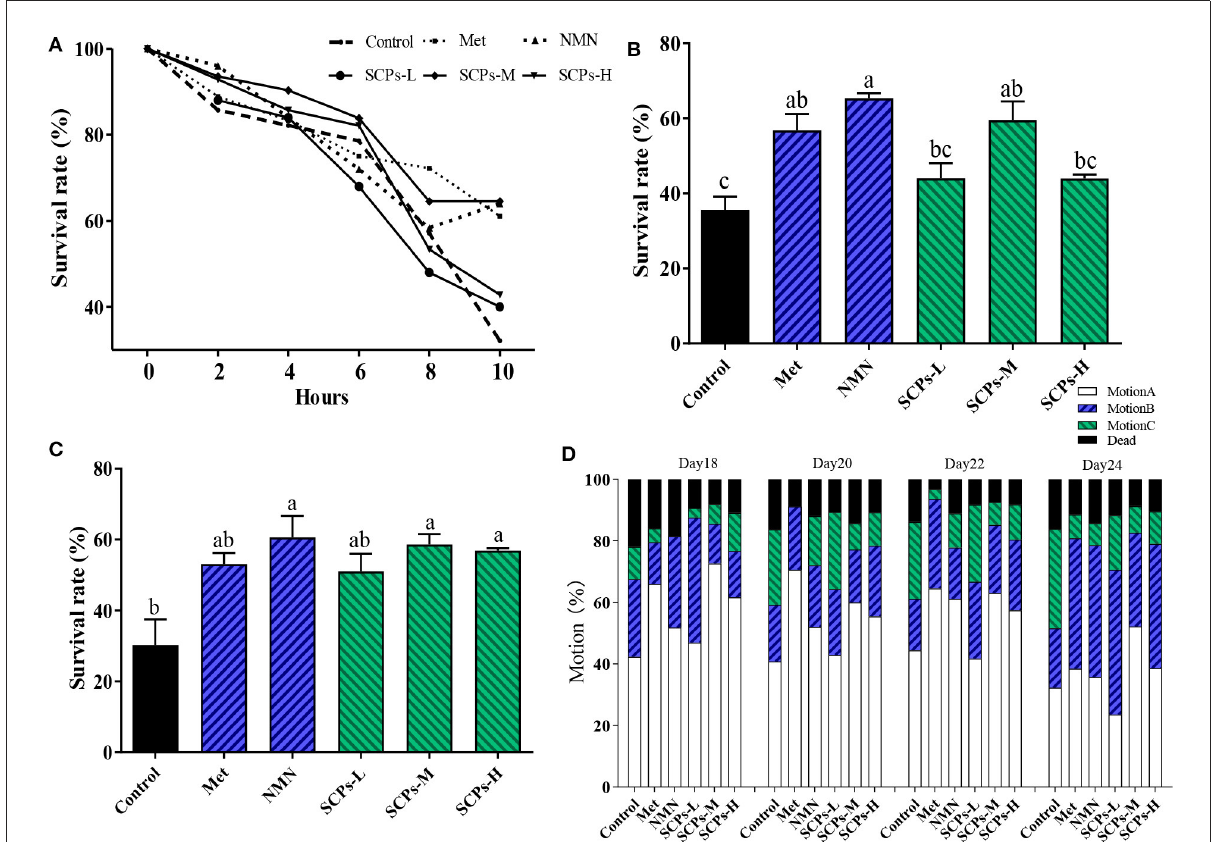
FIGURE3 Effects of SCPs on the stress and motion ability in N2 over time. (A) Effect of SCPs on N2 survival over time under paraquat-stimulated. (B) Effect of SCPs on N2 survival under paraquat-stimulated. (C) Effect of SCPs on the survival of N2 at 37 ◦ C thermal shocks. (D) The effect of SCPs on the mobility of N2. The movement is the free crawling as action A; the body twisting or head twisting after the platinum wire is lightly touched as action C; between the two is action B. Different letters correspond to statistically significant differences ( p < 0.05) between